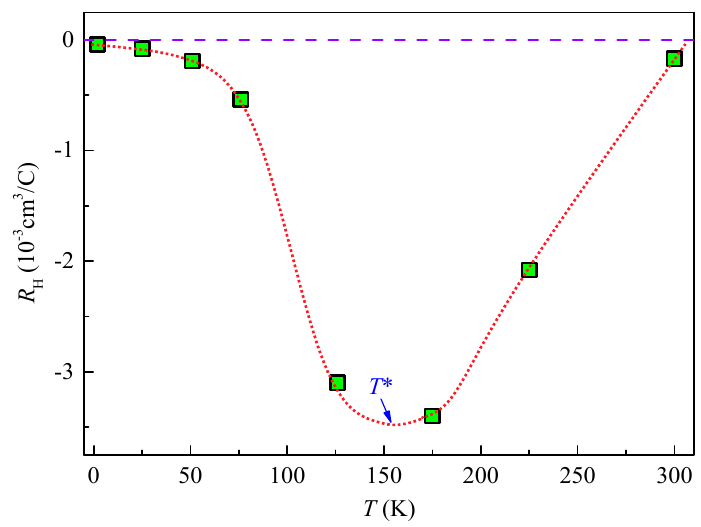
Figure 12. Temperature-dependent R H of single-crystal (Li 1- x Fe x )OHFeSe. The point-dashed curve is a guide for the eyes.